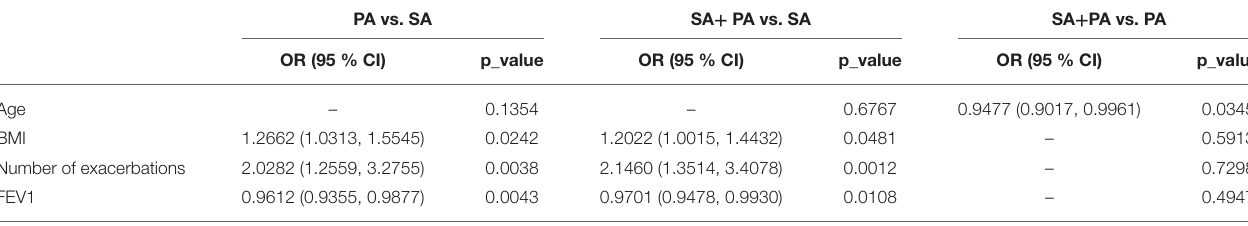
TABLE 3 | Adjusted odds ratios of cystic fibrosis patients’ infection status.